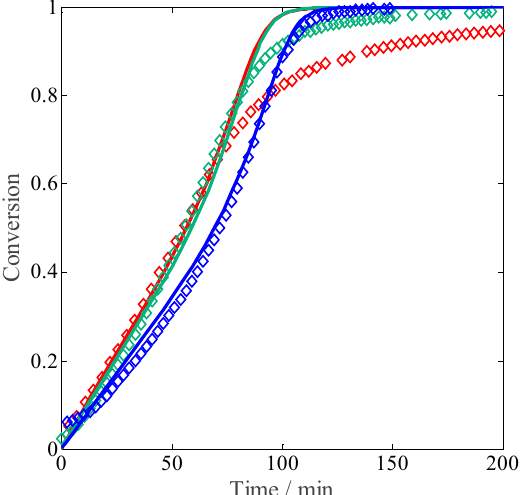
Figure 1. Monomer conversion versus time profiles of the radical batch polymerization of non ‐ ionized methacrylic acid (MAA) in aqueous solution at 50 °C, 0.02 wt % of 2,2 ′‐ azobis(2 ‐ methylpropionamidine) dihydrochloride (V ‐ 50) initiator, and initial monomer concentration equal to 1 wt % (red), 5 wt % (green), and 10 wt % (blue): comparison between experimental data by in ‐ situ nuclear magnetic resonance (NMR) (diamonds) and simulated curves (lines).